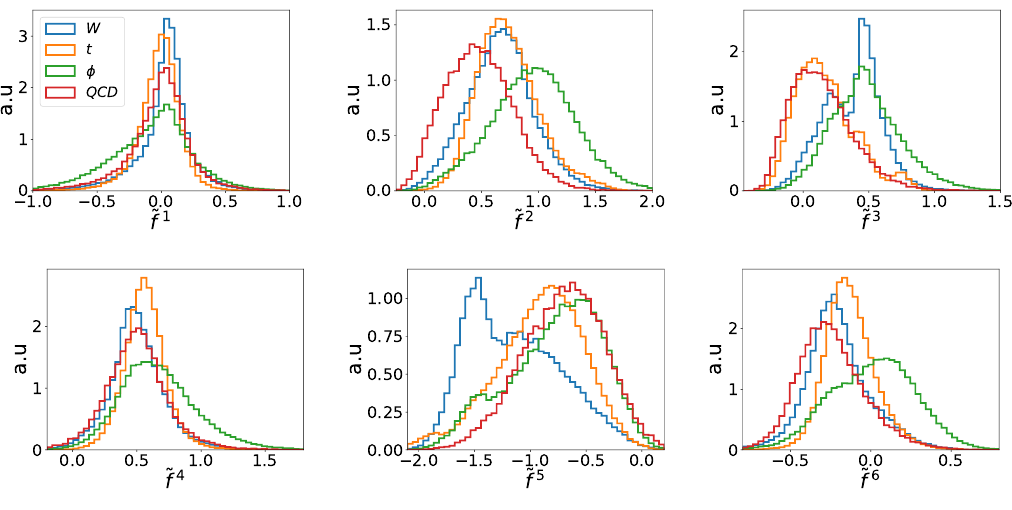
Figure 6 . The distribution of six dimensional latent space after the training is performed only on QCD jets.